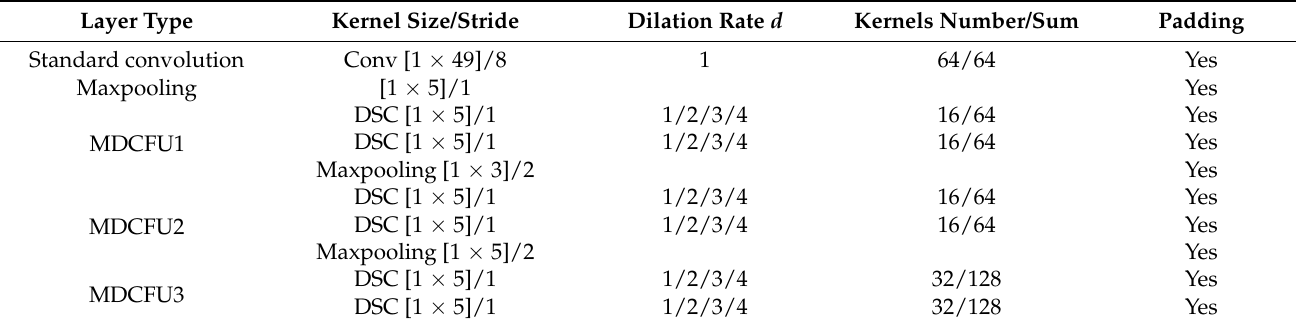
Figure 6. Architecture of the proposed MsDCN. Table 1. Parameter setting of network.